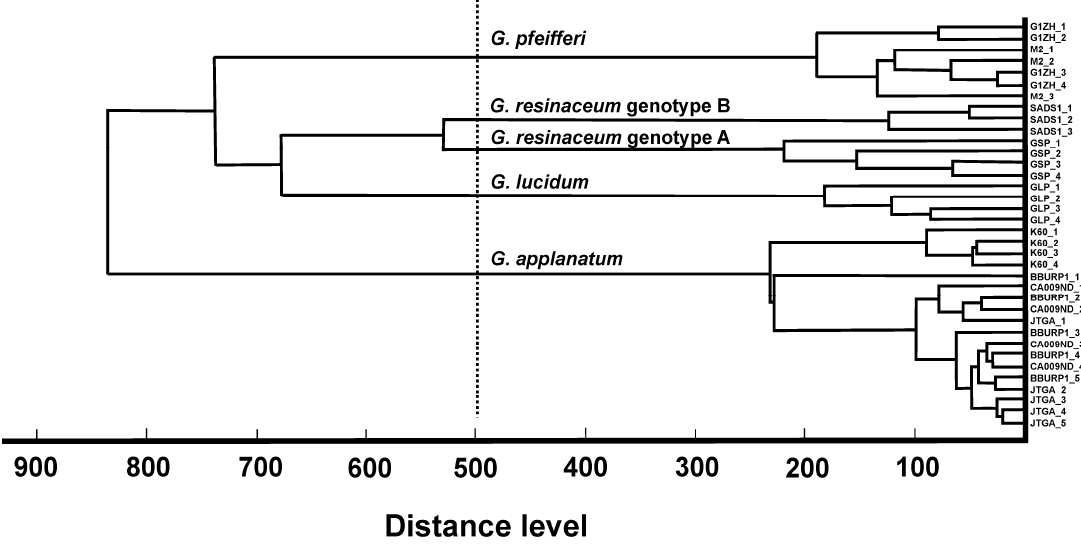
Figure 5. Similarity dendrogram of Ganoderma spp. strains based on MALDI–TOF spectra comparisons. The vertical line at distance value 500 indicates cutoff score for species delineation. Numbers after strains designation indicate biologic replicates.